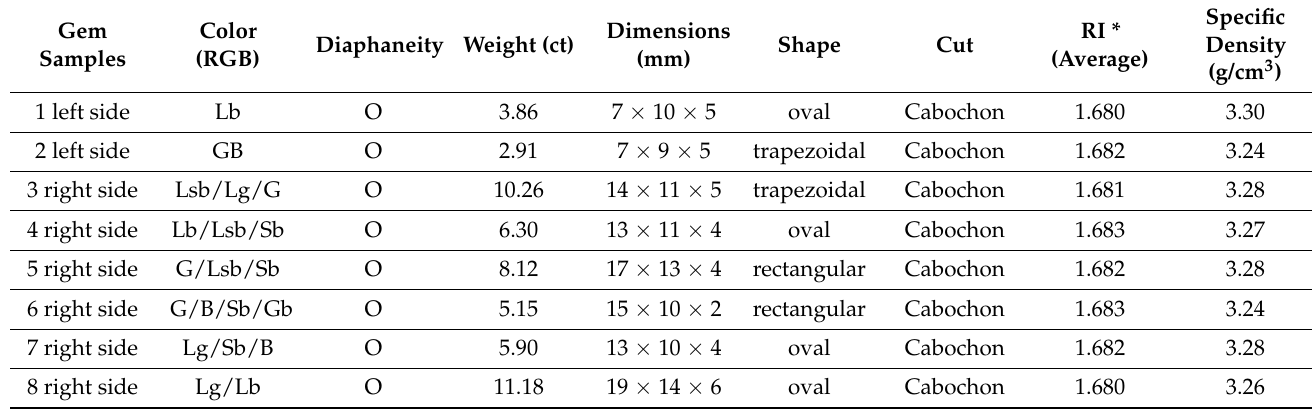
Table 1. Physical and gemological properties of the studied samples. Lsb = light steel blue; Lg = light grey; G = grey; B = blue; Lg = light grey; Sb = steel blue; Lb = light blue; Gb = greenish blue. * RI measured by the distance